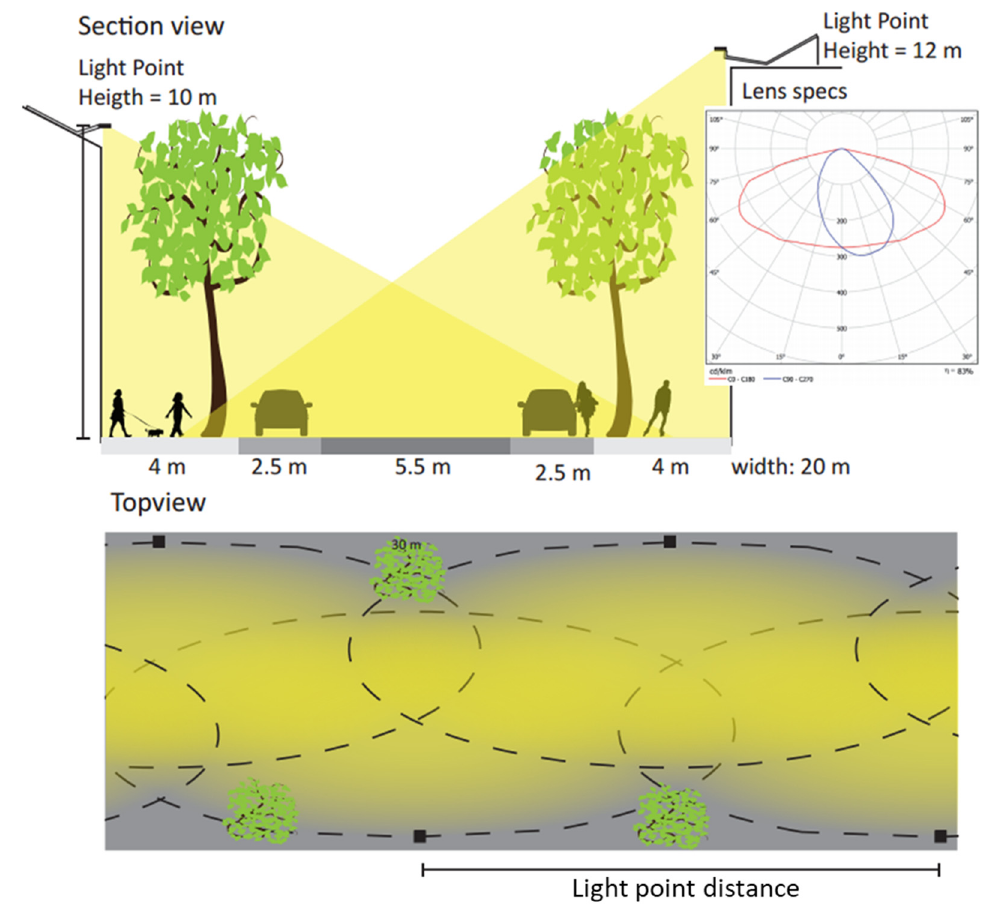
Figure 12. Light design proposal with small and asymmetric beam to avoid light shining into houses.